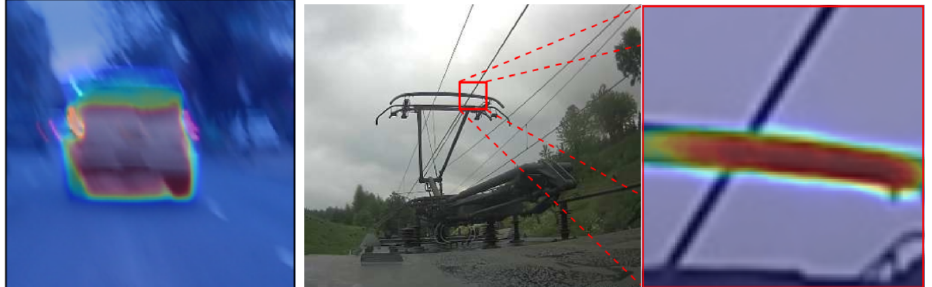
Figure 20. Failure case of the proposed method by Wang et al. [68]. The proposed method fails when faced with motion blur or a “non-object” pattern. Reprinted from [68].